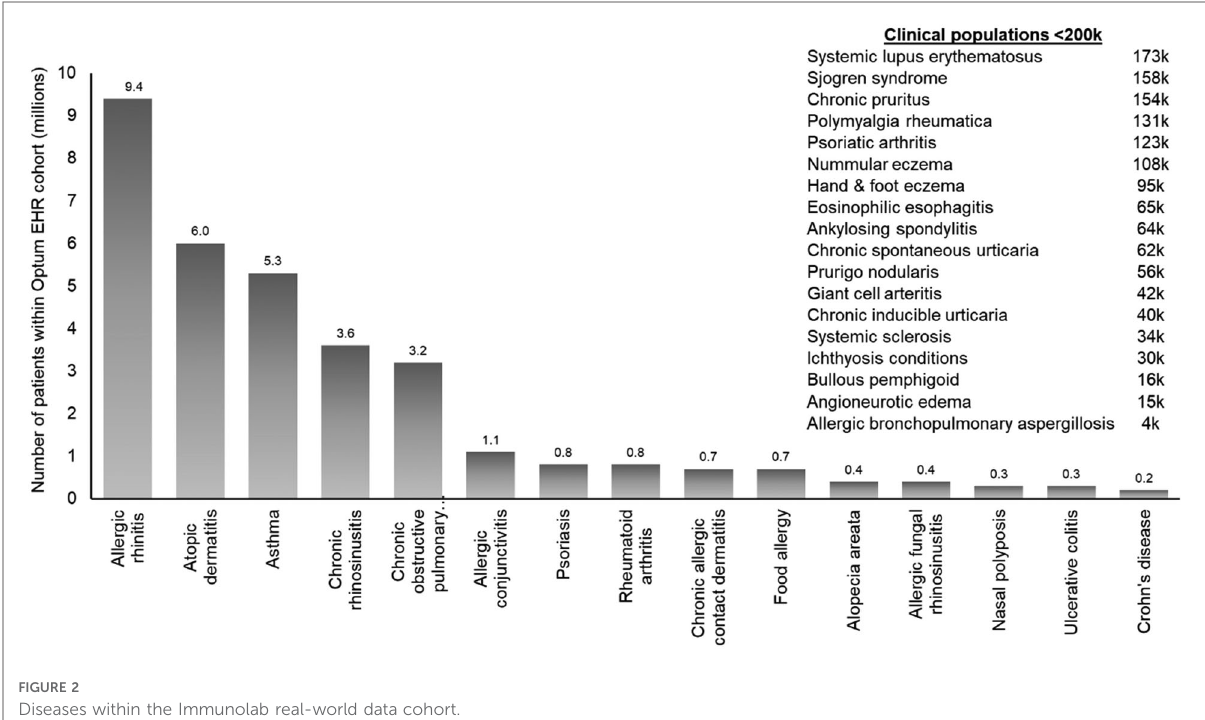
FIGURE 2 Diseases within the Immunolab real-world data cohort. COPD, chronic obstructive pulmonary disease; EHR, electronic health record; RW,